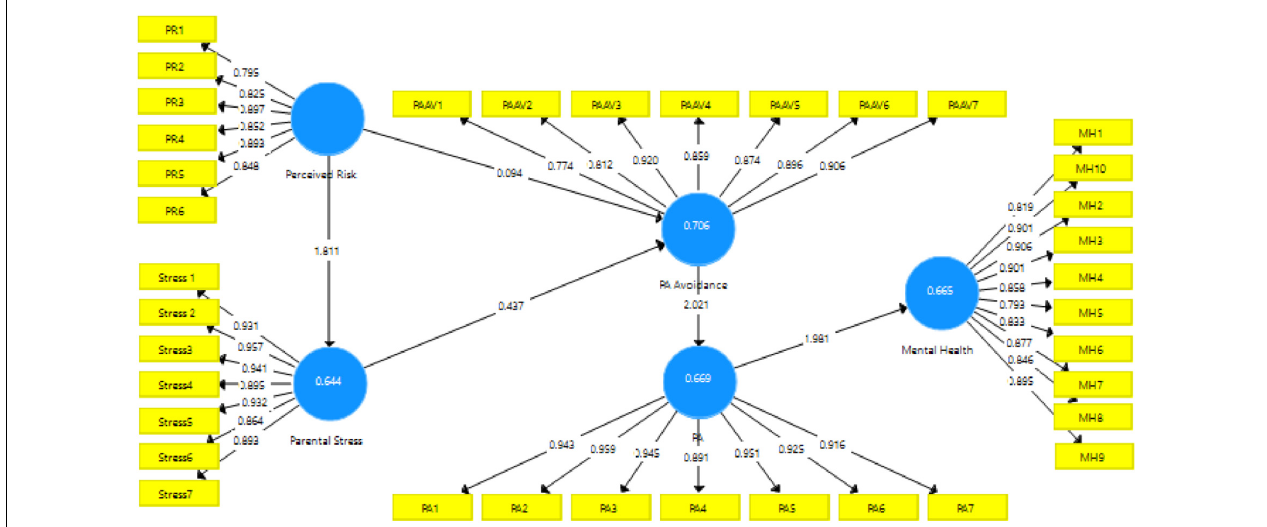
FIGURE 2 | Parent’s influence on children’s PA and mental health during